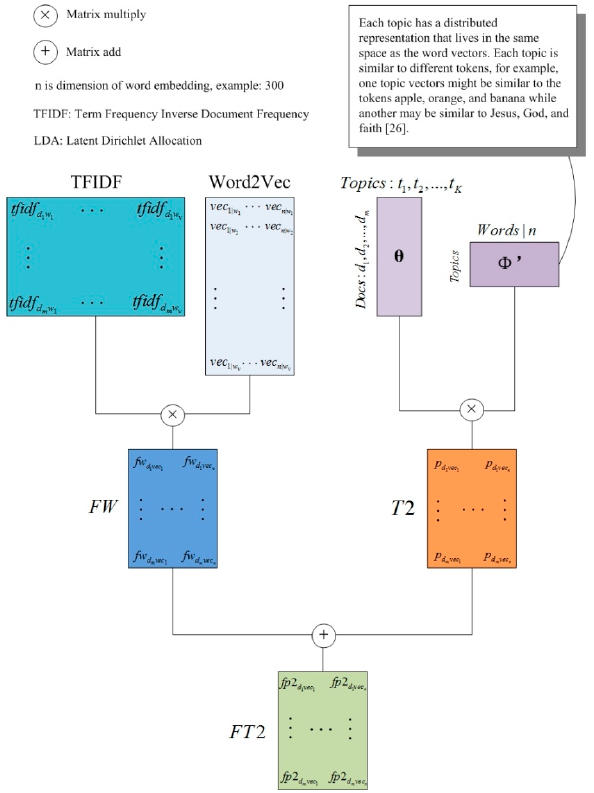
Figure 4. Second kind of feature probability (FP2) model.